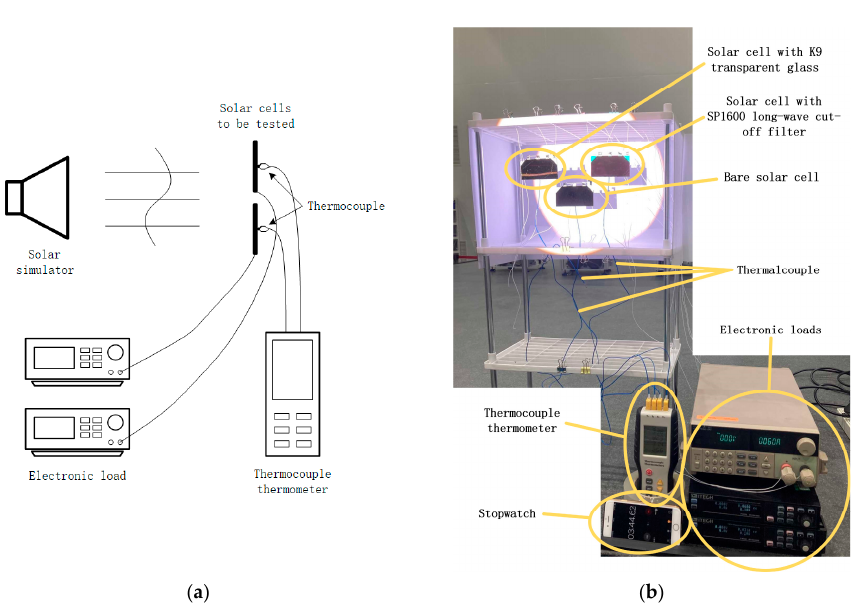
Figure 7. Materials used in the test. ( a ) Filter and transparent glass. ( b ) Solar cell with filter, with glass and with no covering.